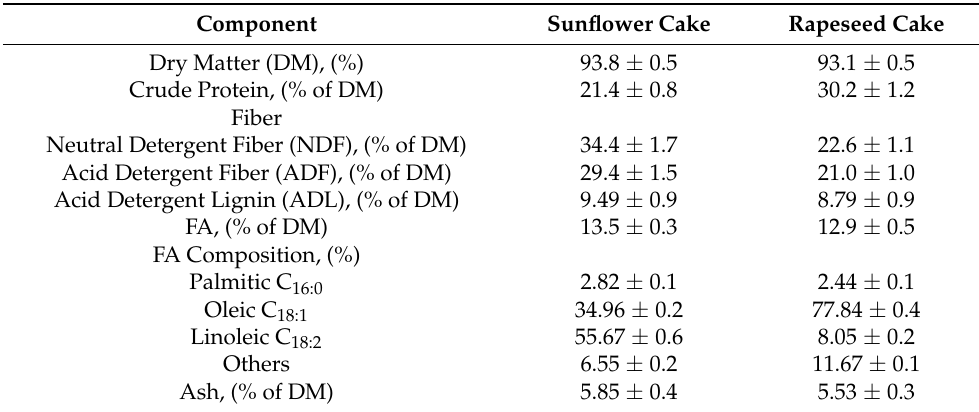
Table 1. Composition of oil seed